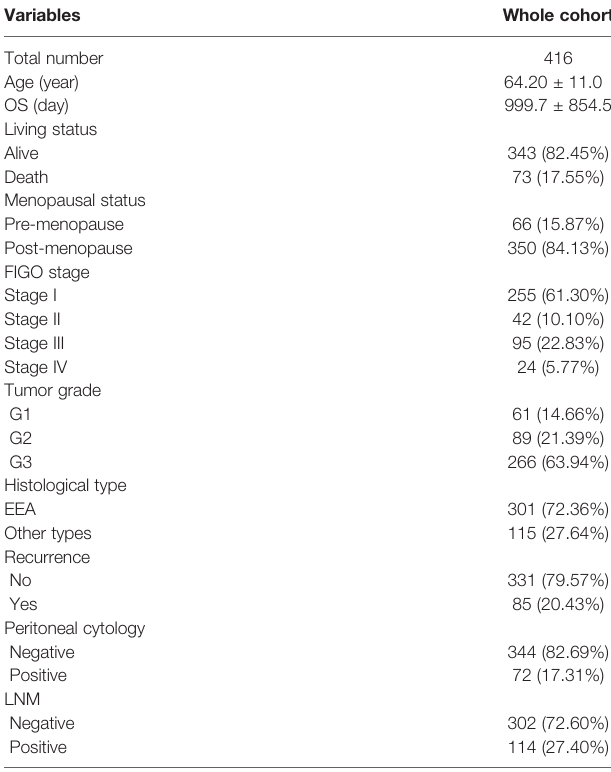
TABLE 1 | Characteristics of patients in training cohorts from TCGA